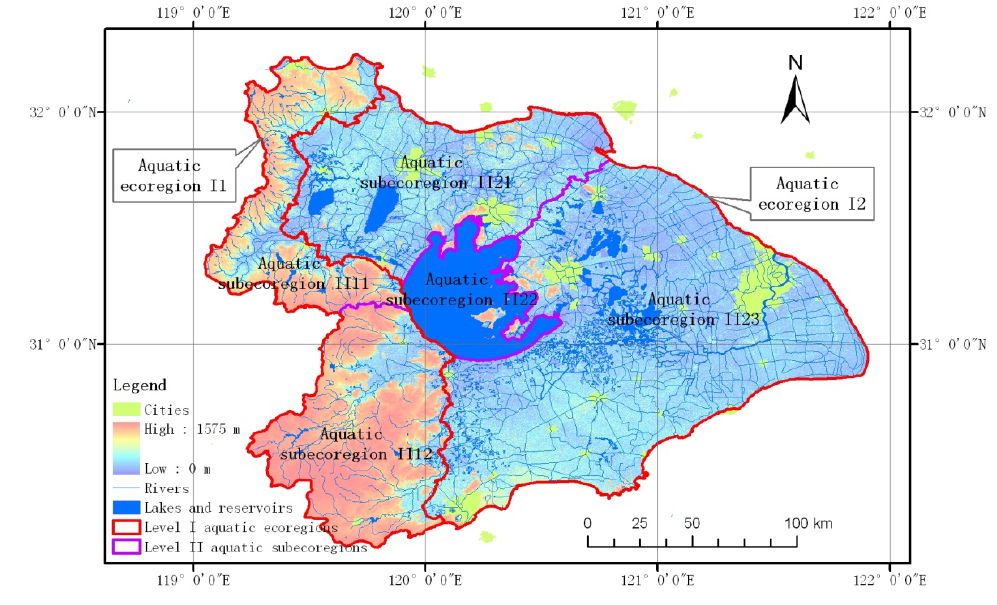
Figure 3. Level I aquatic ecoregions and level II aquatic subecoregions in the Taihu Lake watershed.